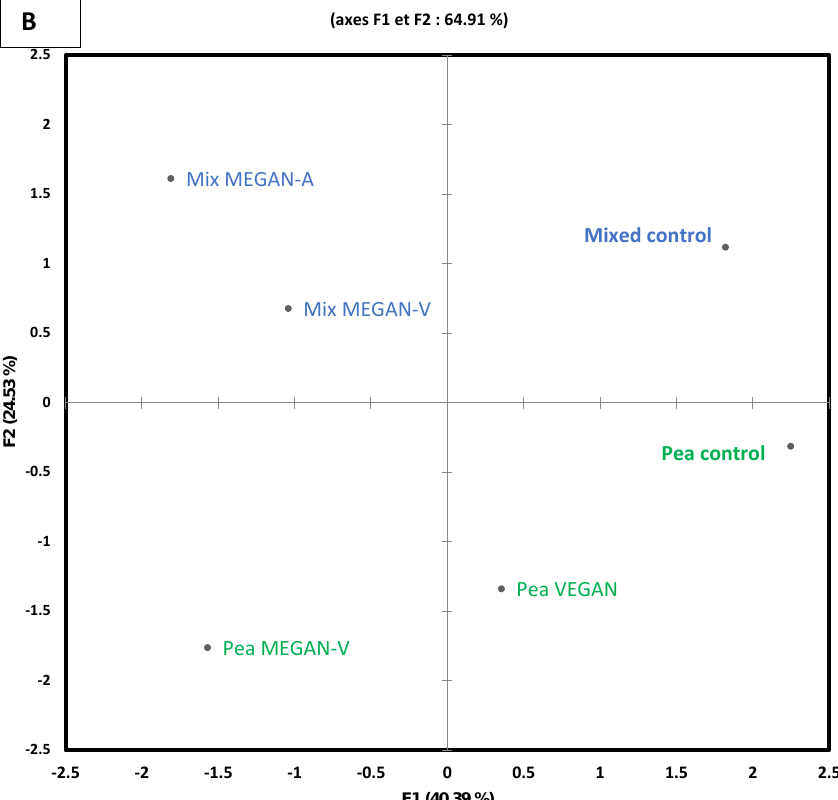
Figure 4. MFA analyses performed with sensory variables, volatile compounds, and amino acids composition of the different pea and mixed gels. Red: sensory attributes, Green; volatile compounds, Blue; amino acids. RV coefficients were (sensory attribute-volatile compounds = 0.77)/(sensory attribute–amino acids) = 0.45)/(amino acids—volatile compounds = 0.72). ( A ) map of sensory attributes, volatile compounds, and amino acids composition, ( B ) map of pea (Green) and mixed (Blue) products (not fermented gel and fermented gel) at three days with the different microbial consortia: VEGAN, MEGAN-A, and MEGAN-V.